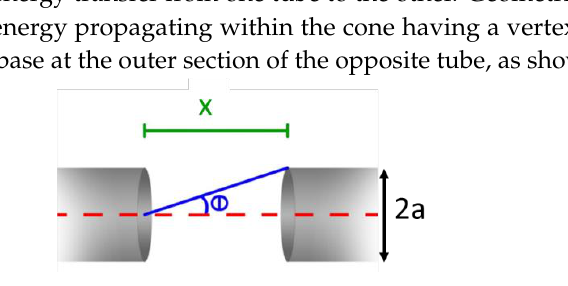
having height x , vertex angle θ , and base 4 π a 2 is supposed to couple with the opposite tube.